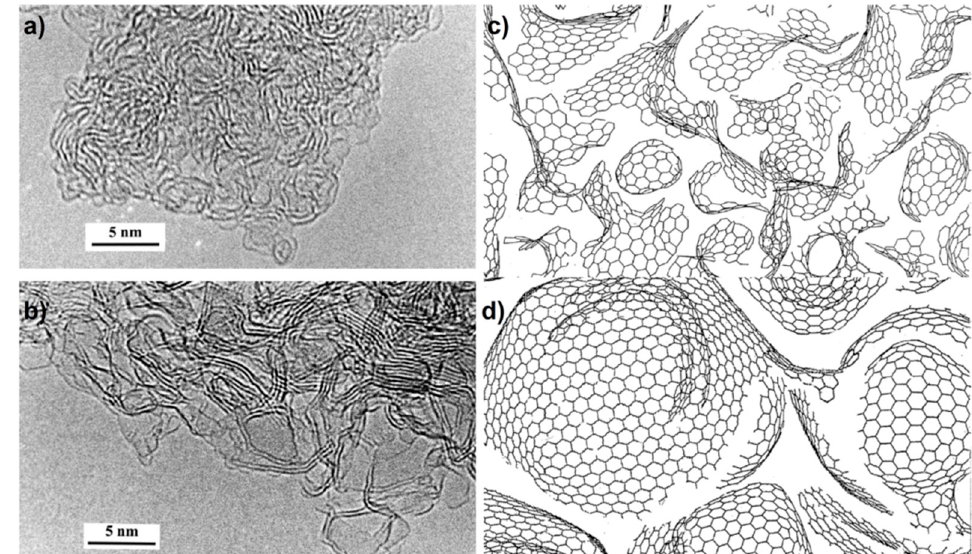
Figure 16. ( a ) TEM images of commercial Sigradur K glass-like carbon prepared at 1000 °C and ( b ) Sigradur G glass-like carbon prepared at 2800 °C. ( c ) Models for the fullerene-like structure of low-temperature and ( d ) high-temperature glass-like carbon proposed by Harris. Reproduced with permission from Harris [7]. Copyright Taylor & Francis, 2004.